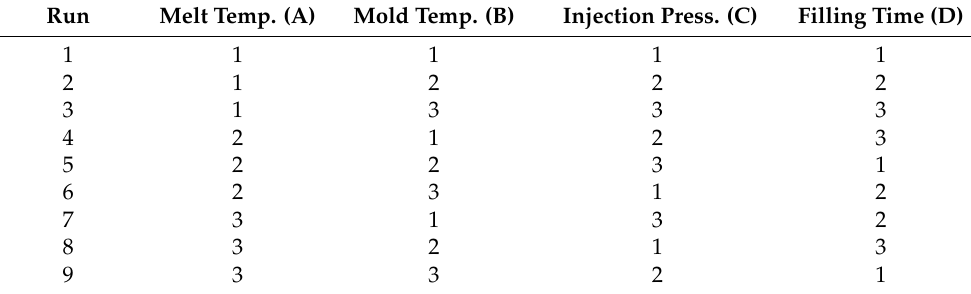
Table 2. The L 9 orthogonal array used in the main experiment. Run Melt Temp. (A) Mold Temp.